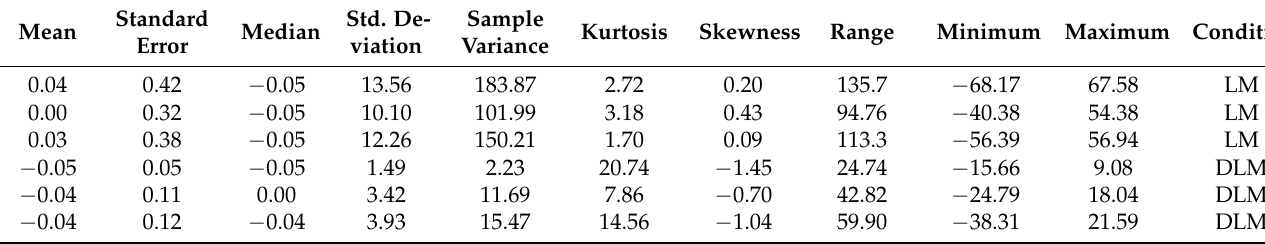
Table 4. Extracted features from the experimental data.